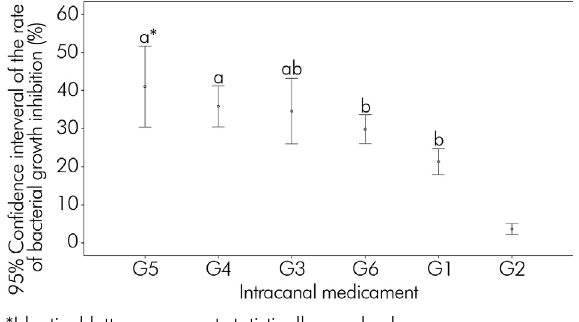
*Identical letters represent statistically equal values. Figure 1. Graphical representation of the 95% confidence intervals for growth rate inhibition according to the tested intracanal